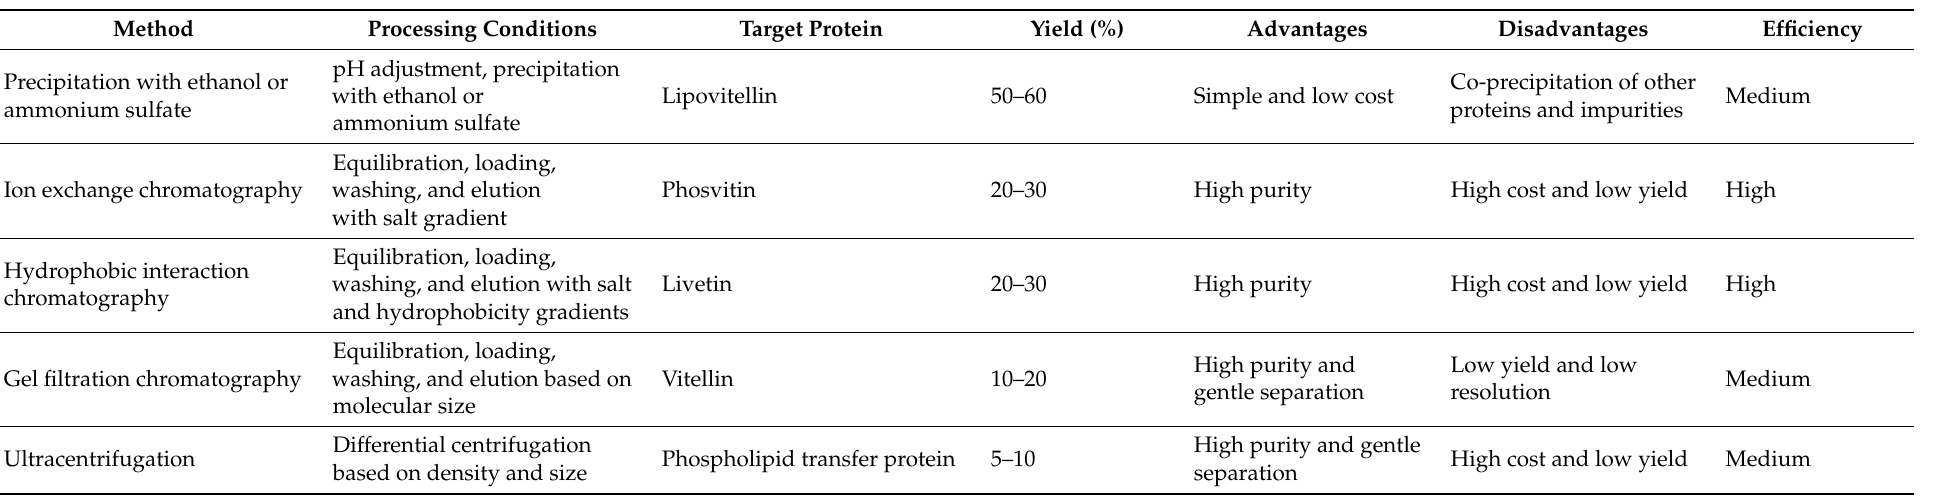
Table 2. Multiple methods for fractionating the primary proteins in egg